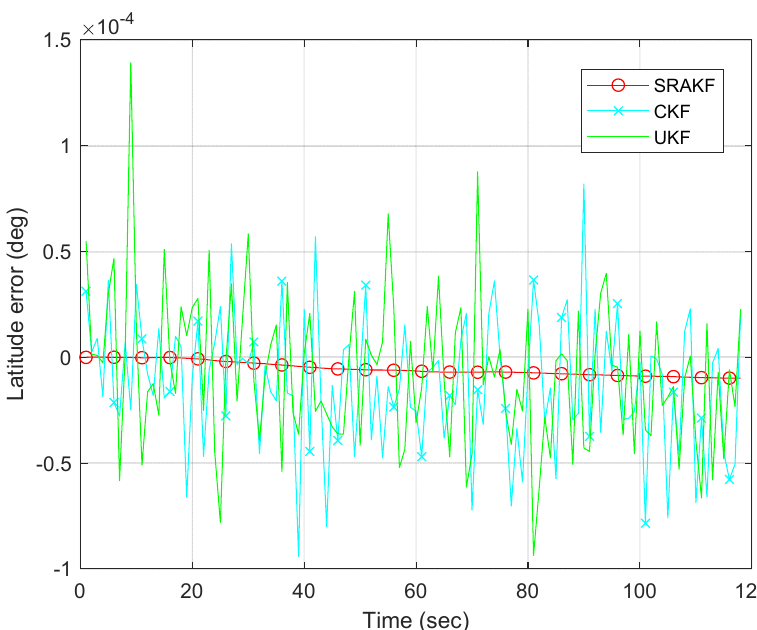
Figure 17. Latitude errors for the robustness lake trial.